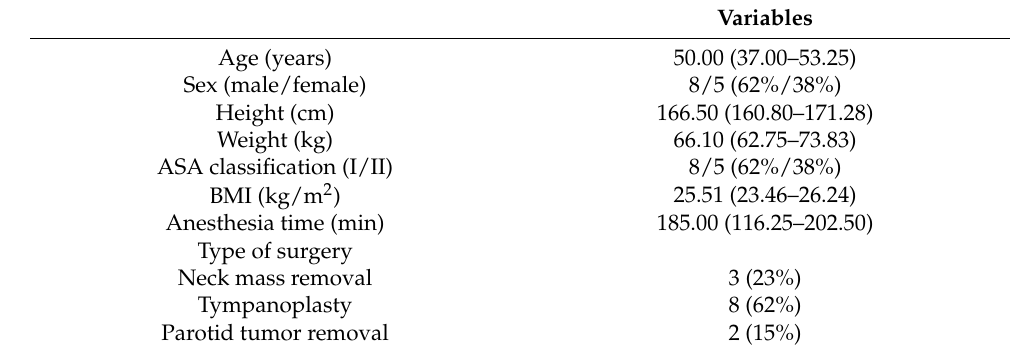
Table 1. Demographic features of the subjects.